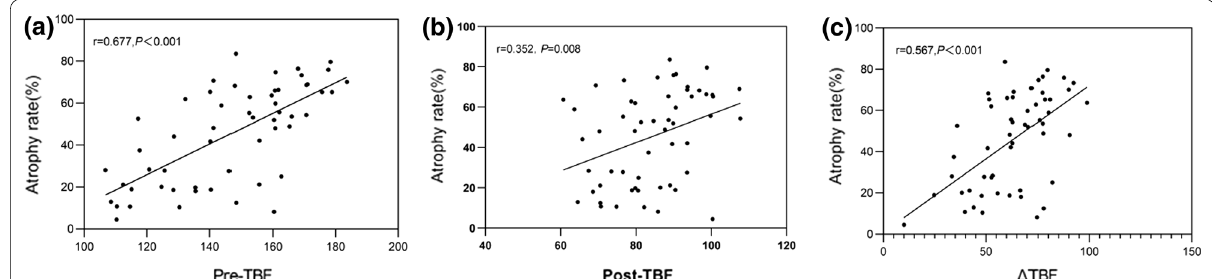
Fig. 6 Scatterplots showing correlations between ASL-derived parameters and the tumor atrophy rate. Pre-TBF: pre-treatment tumor blood flow;